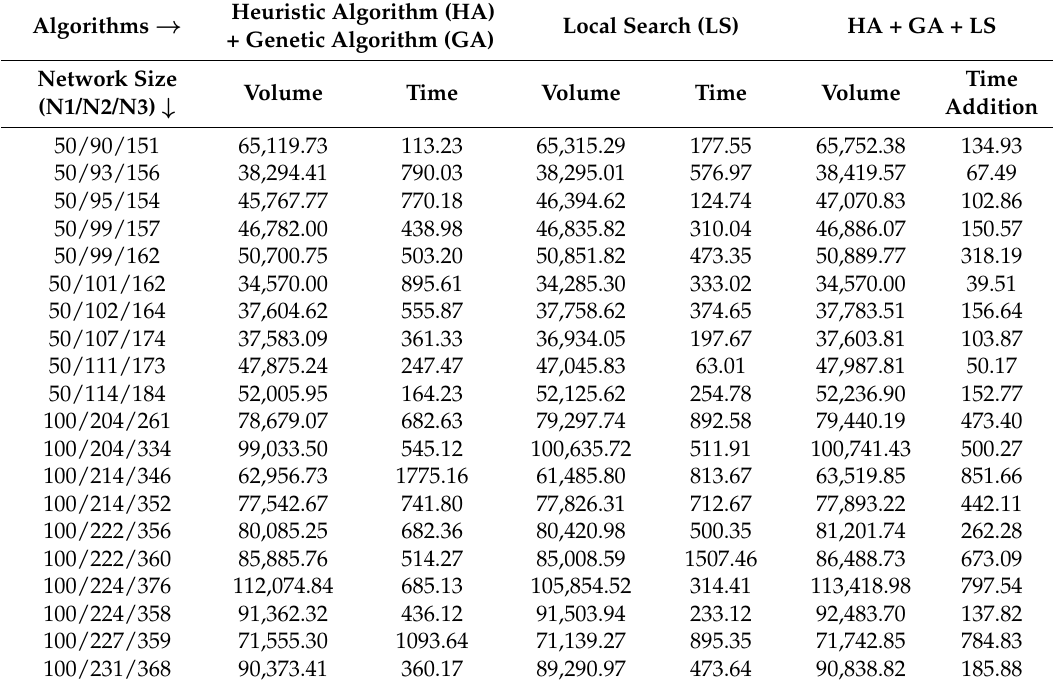
Table 4. Computational results of the three algorithms for the artificial networks with different scales.